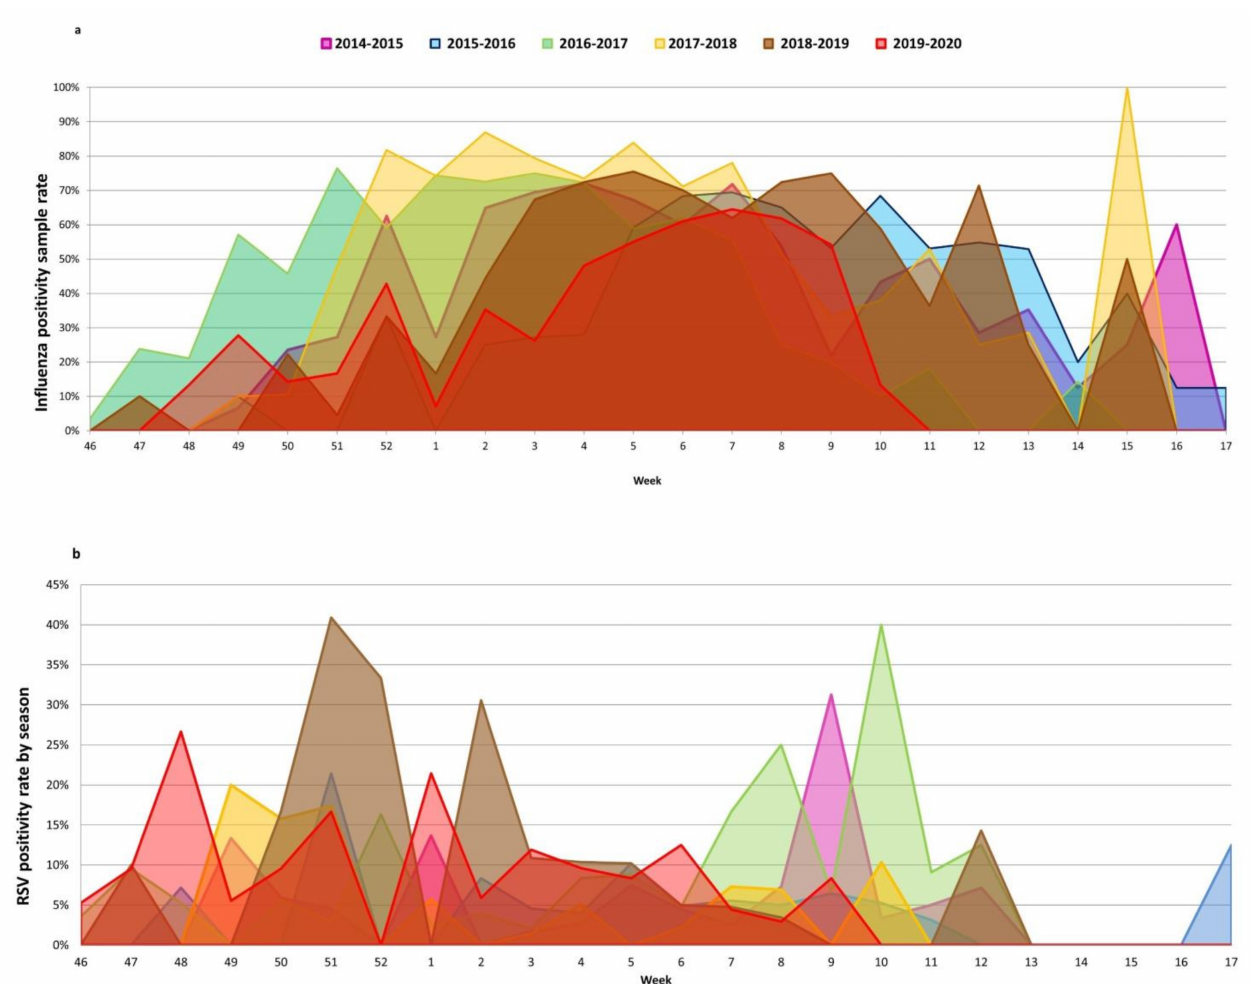
Figure 2. Comparison of positivity rates of influenza virus ( a ) and RSVs ( b ) by week of sample collection between the